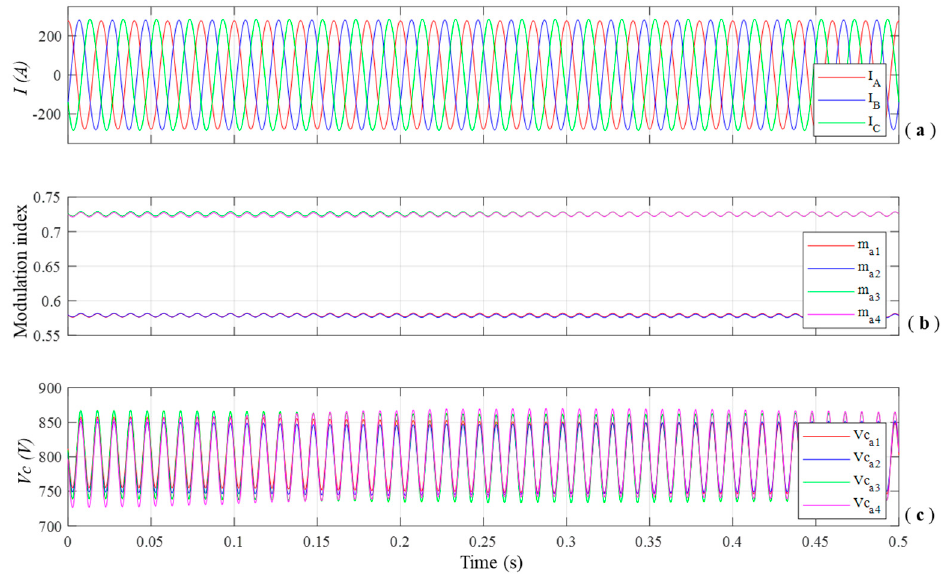
Figure 11. ( a ) Injected currents, ( b ) modulation indexes and ( c ) capacitor voltage of cells from phase A in an unequal power generation scenario.